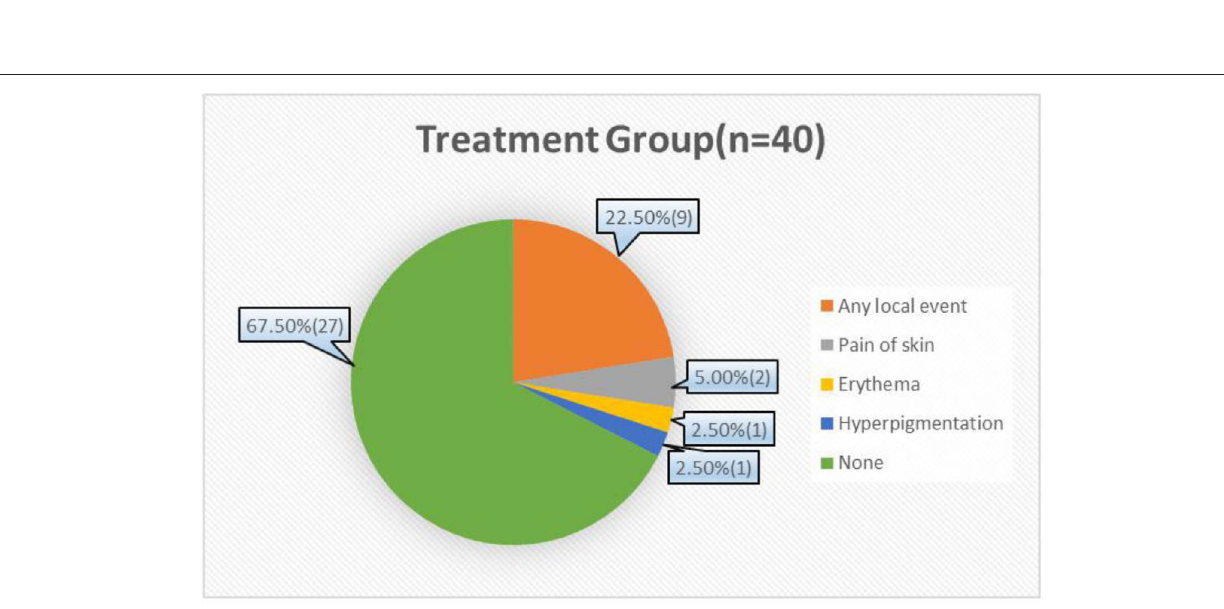
Frontiers in Medicine |